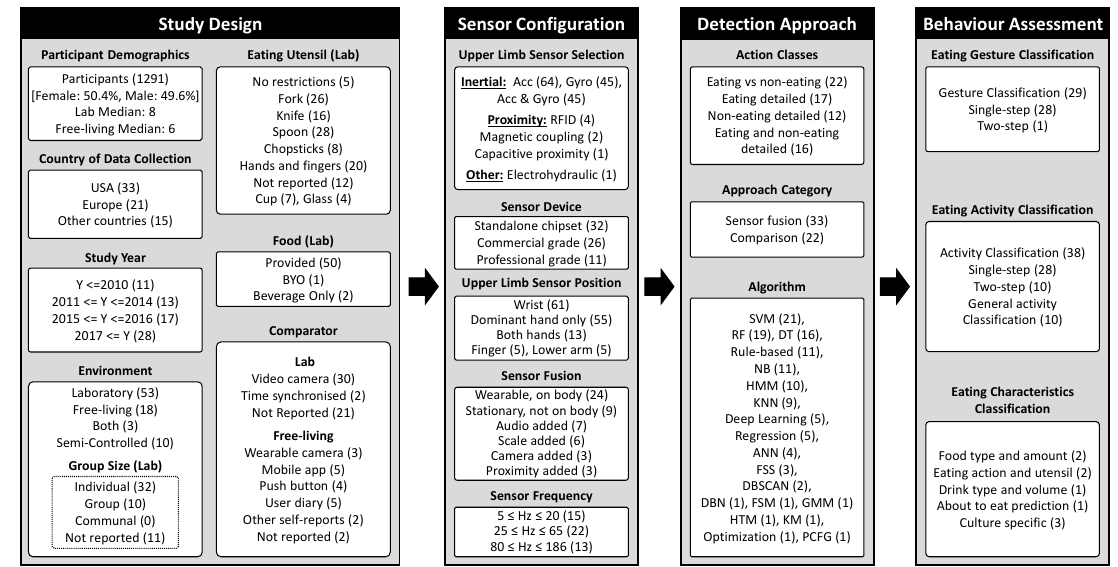
Figure 2. Conceptual framework of components for assessing eating behaviour with upper limb-mounted motion sensors.